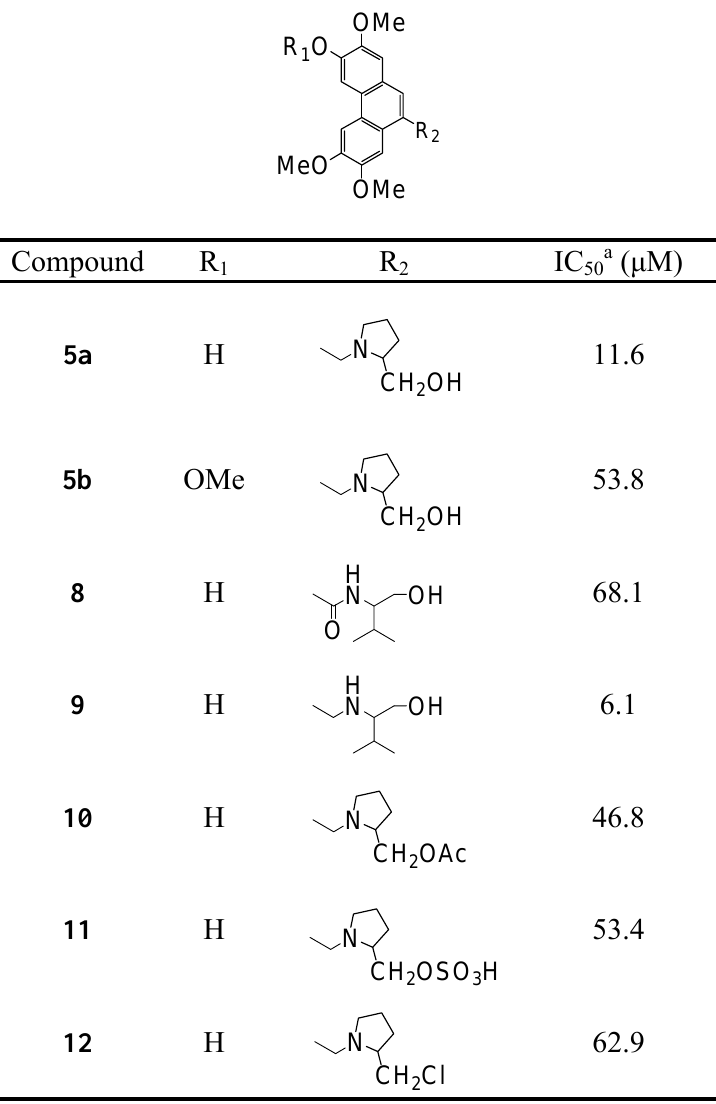
Table 1. The structures of 5a , 5b , 8 - 12 and their cytotoxicities against H460 cell